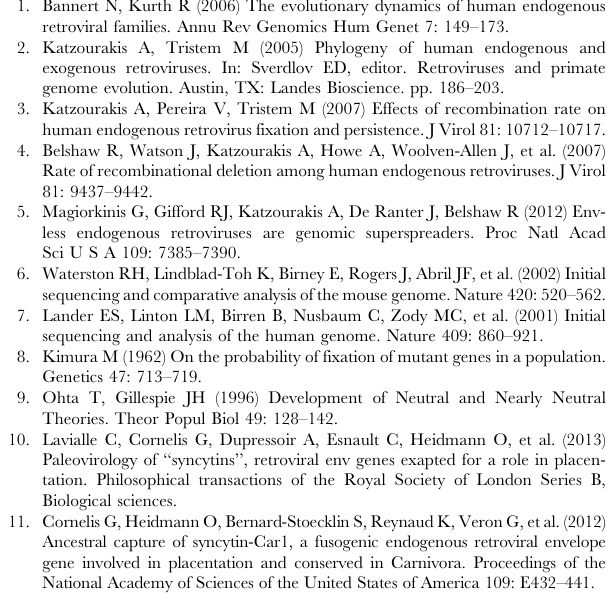
Figure S1 A schematic diagram of the model representing the interactions among four distinct subpopulations: susceptibles ( S ), infected with (exogenous) retrovirus ( I RV ), infected with integrated (endogenous) retrovirus ( I ERV ), and infected with amplified inte- grated (endogenous) retrovirus ( I AERV ). Figure S2 The results of model (1) show that the proportion of the population infected with amplified, endogenous retrovirus (i.e. the AERV -compartment) is associated with a larger body size ( B ), and lower rates of endogenisation ( s ) and force of infection ( l ). The model also predicts that a higher rate of retroviral endogenisation ( s ) and a greater force of infection ( l ) are both linked to a shorter time to reach the endemic steady state. Table S1 Testis size for 24